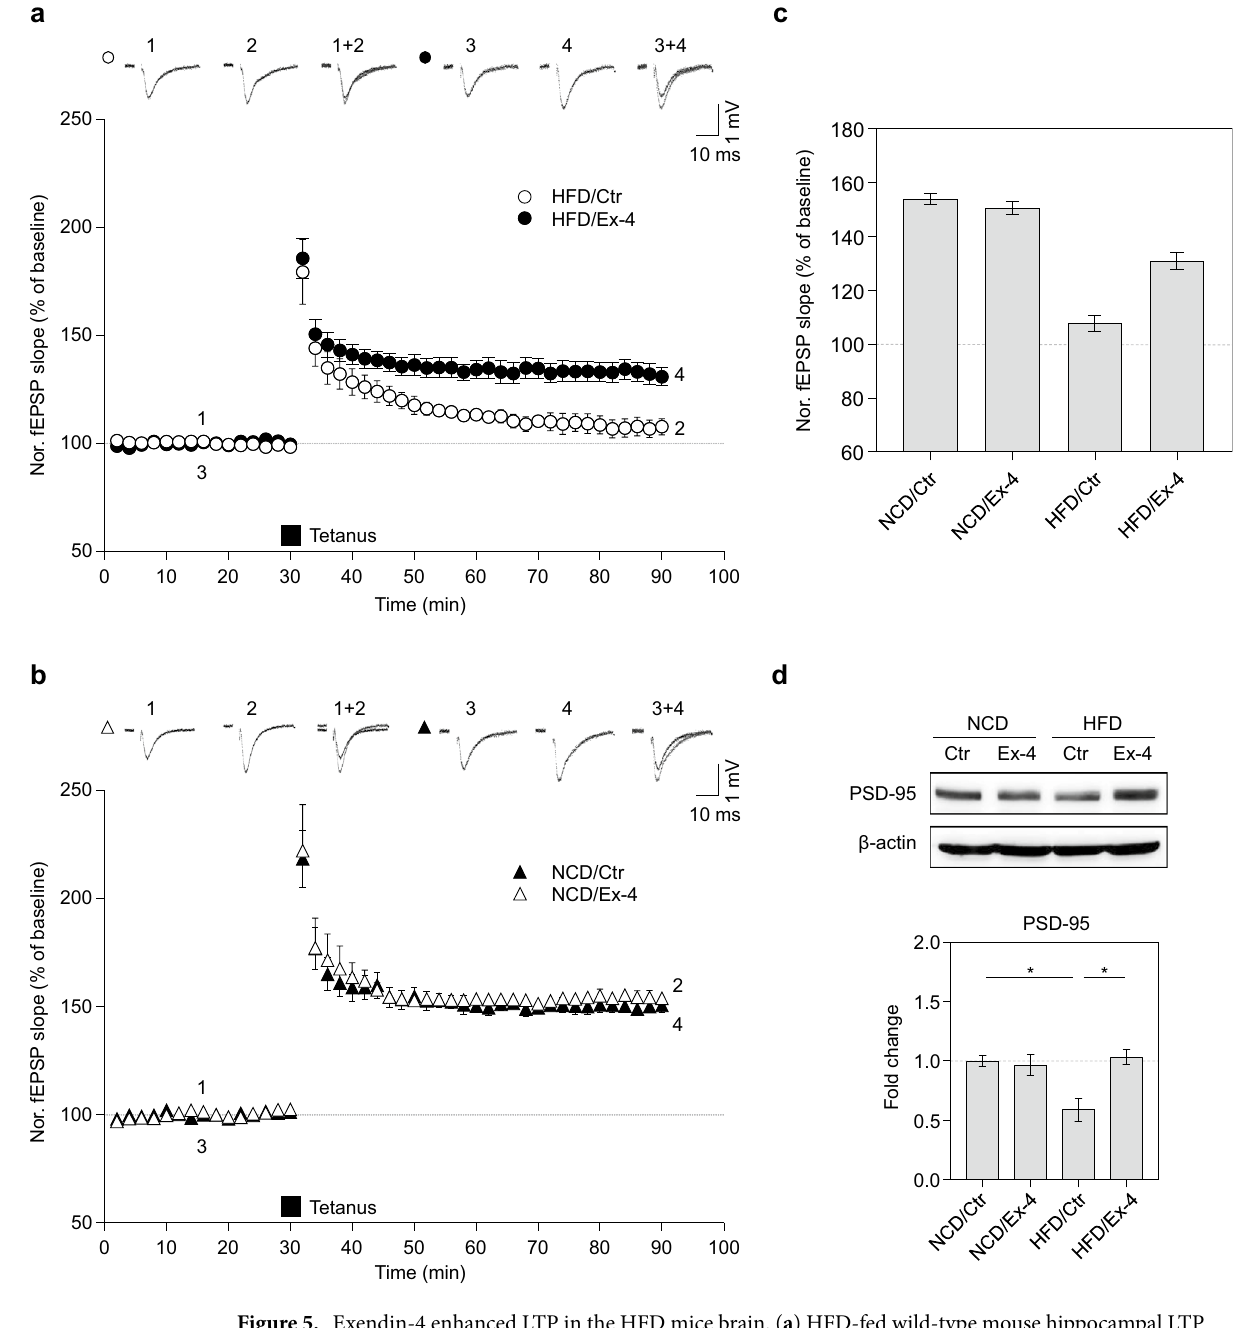
Figure 5. Exendin-4 enhanced LTP in the HFD mice brain. ( a ) HFD-fed wild-type mouse hippocampal LTP was assessed in acute slices of the control group (open circle) and exendin-4 injected group (closed circle), n = 10 per group from 10 animals. ( b ) NCD-fed wild-type mouse hippocampal LTP was assessed in acute slices of the control group (open circle) and exendin-4 injected group (closed circle), n = 10 per group from 10 animals. ( c ) Bar graphs of fEPSP slope after tetanus stimulation between the control and exendin-4 groups in either the NCD or HFD-fed mice hippocampus. ( d ) PSD-95 protein levels in the hippocampus between the